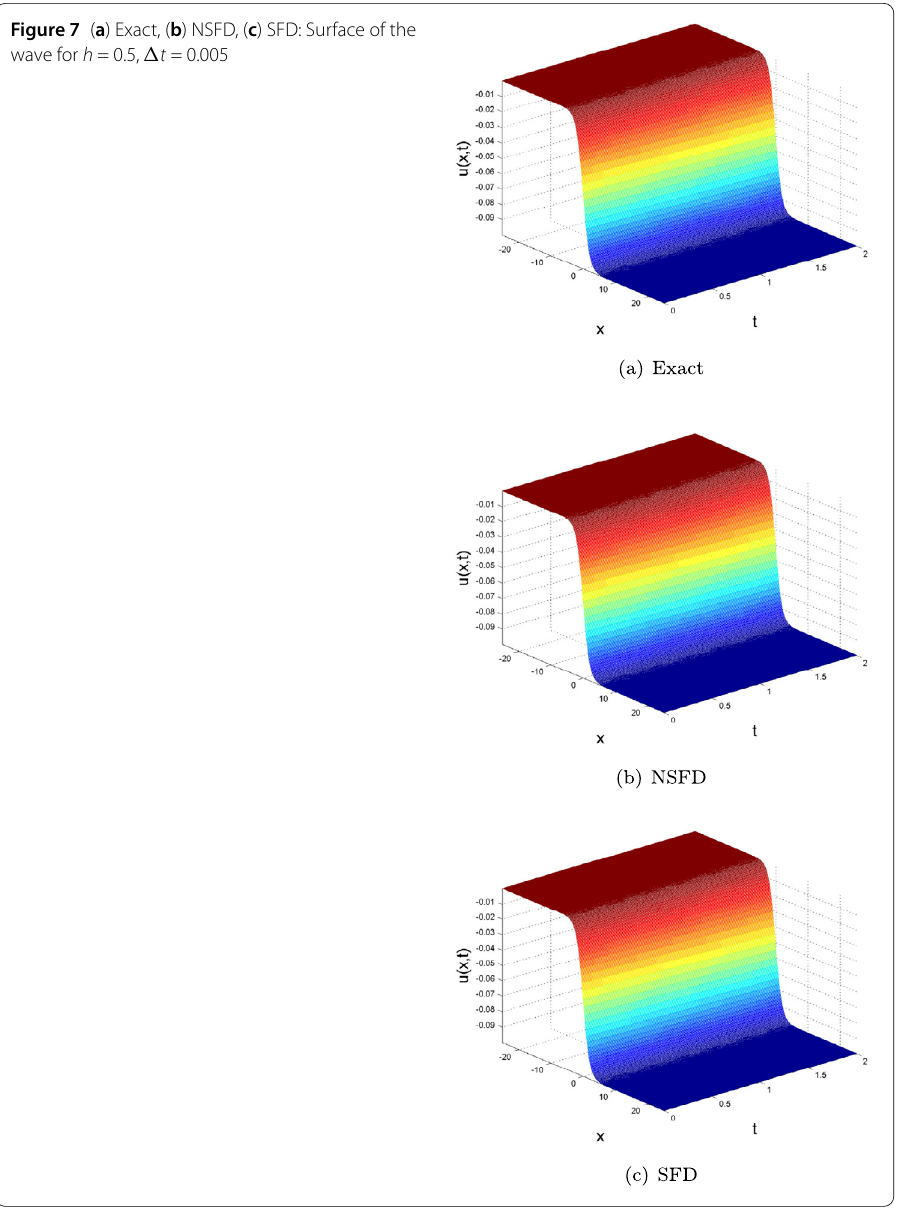
small h and (cid:3) t . To verify this fact, we choose h = 0.5, (cid:3) t = 0.005 and depict the solution in Fig. 7. Figures 8–9 represent the absolute errors and the L ∞ , L 2 errors, respectively. From these figures, we see that the NSFD scheme is efficient as well as the SFD scheme. Tables 3 and 4 represent the L ∞ and L 2 -errors of the exact finite difference methods, IMPEXFDI (18), IMPEXFDII (21), IMPEXFDIII (24), EXPEXFDI (27), EXPEXFDII (30), EXPEXFDIII (33). If we select the step size h = 0.5 with different time steps (cid:3) t , the exact schemes are reduced to the NSFD scheme [39]. Figure 10 shows the L ∞ and L 2 -errors of the exact schemes as h = 0.5 with different time steps (cid:3) t